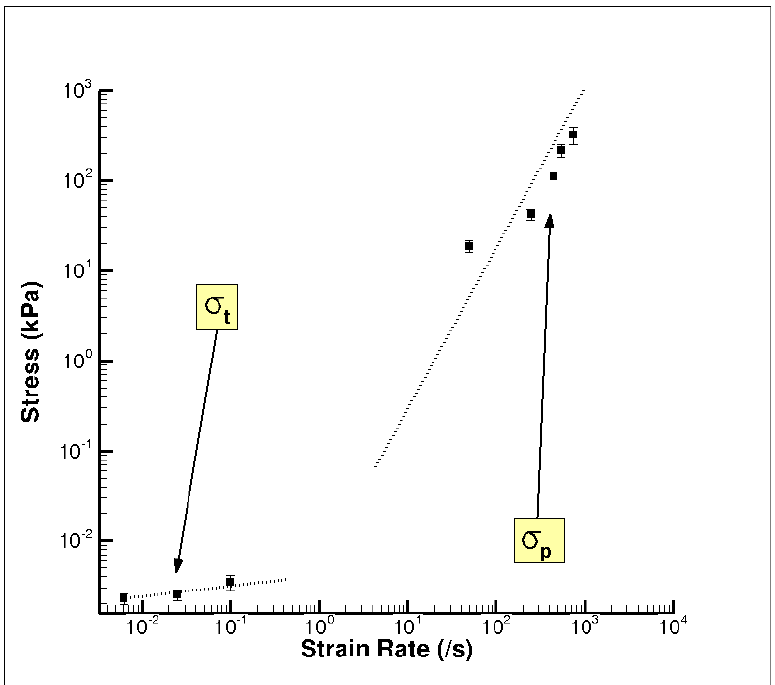
Figure 9. Comparison of the elastic–inelastic transition stress, σ t , and the initial hardening peak stress, σ p , of the wet porcine brain at varying strain rates using a log–log scale. The water content of the wet porcine brain was ~80% m/m. All 39 brain samples were analyzed. The error bars represent standard error.